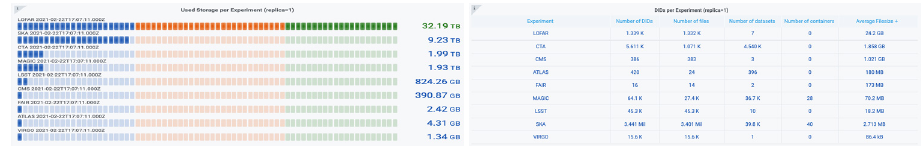
(a) Used storage per experiment (b) Files per experiment Figure 7: Rucio stats